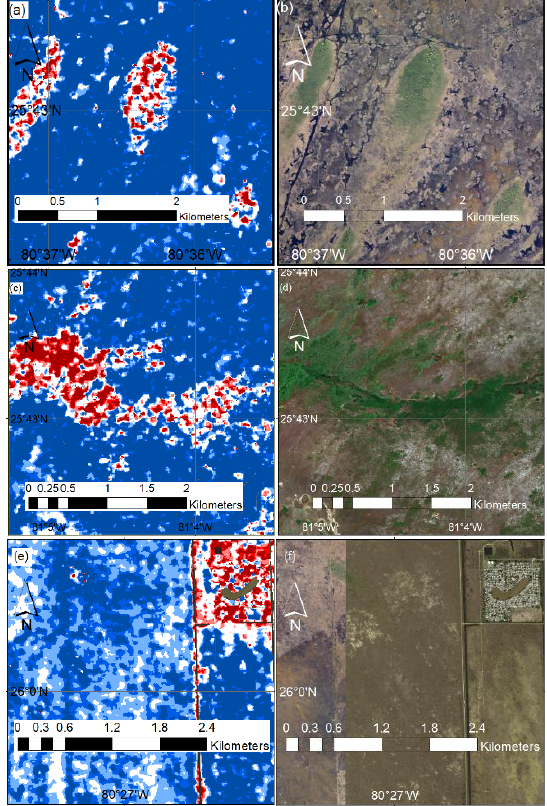
Figure 6. Normalized scattering change values ( t ) and their land cover characteristic obtained from satellite images in three selected locations. (a), (c) and (e) are zoom-in view of three yellow frames in Figure 5. (b), (d), (f) are the corresponding optical remote sensing images. The color ramp of the normalized changes is the same with Figure 5. (a) and (b) Changes in the northern Shark Valley Slough showing scattering decrease over short vegetation, scattering increase over tree islands with tall vegetation (c) and (d) Changes in the western Everglades showing mostly scattering increase over forests and scattering decrease over areas with short vegetation. (e) and (f) Changes in eastern Everglades along the boundary with urban area, demonstrating scattering increase in the up right corner urban area and scattering decrease for the rest of the image. The elevated linear shape structure also shows increased backscattering.